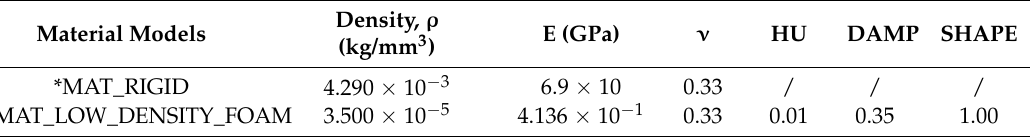
Table 1. Material models used in the simulation and constitutive parameters. HU: hysteretic unloading factor; DAMP: viscous coefficient; SHAPE: shape factor for unloading.